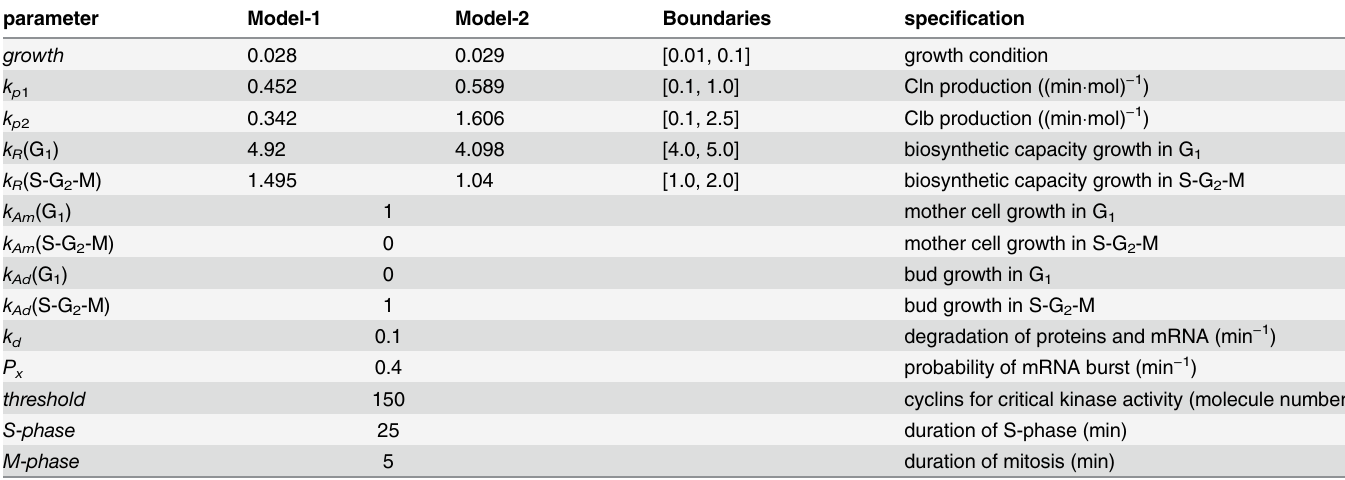
Table 2. Model parameters.